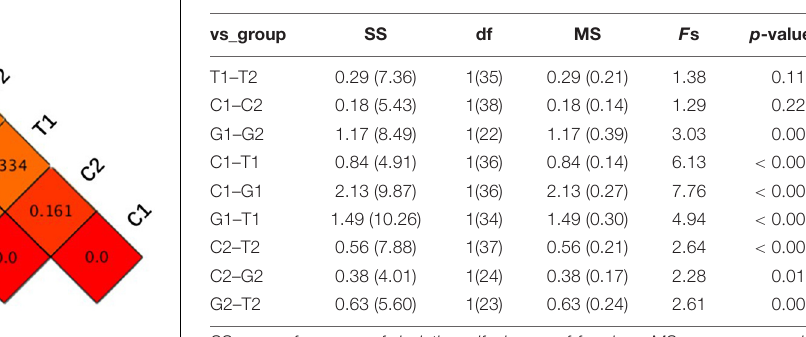
TABLE 3 | Analysis of differences between groups based on the analysis of molecular variance